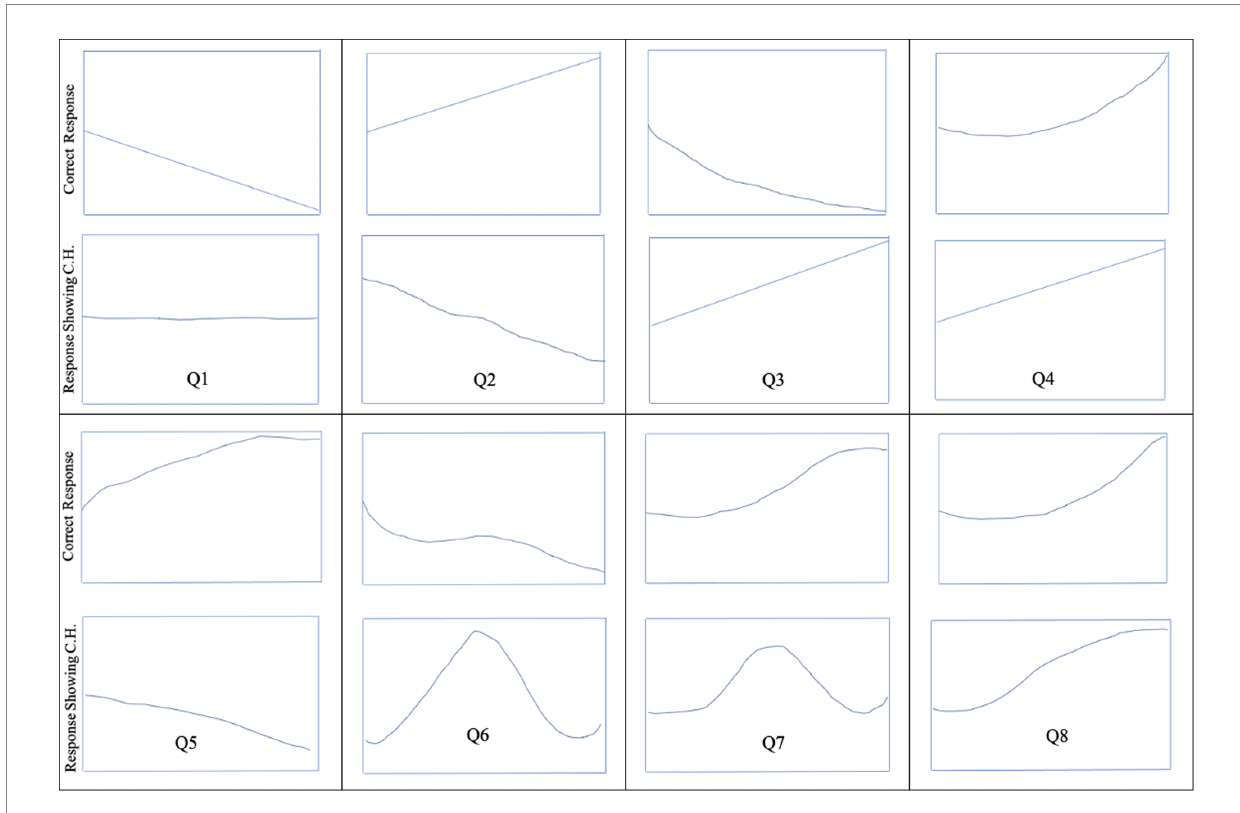
FIGURE 4 Participant’s typical sketch for correct response and response showing correlation heuristic to the eight